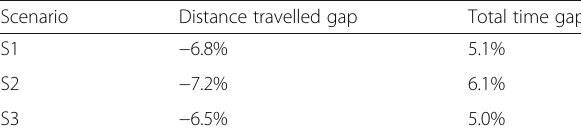
Table 5 Percentage gap for distances and times of VRP-ANNONA with respect to VRP-SS